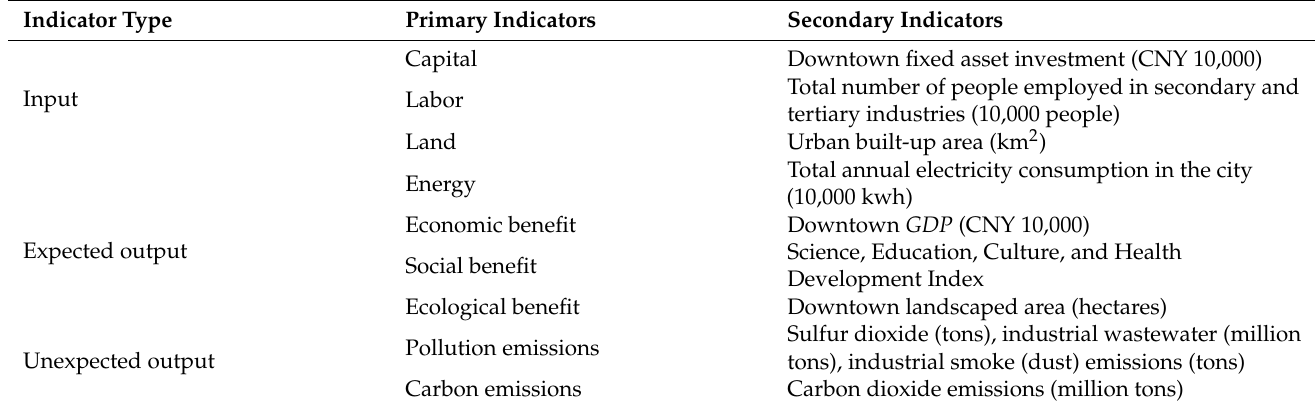
Table 1. The Evaluation system of urban land green use